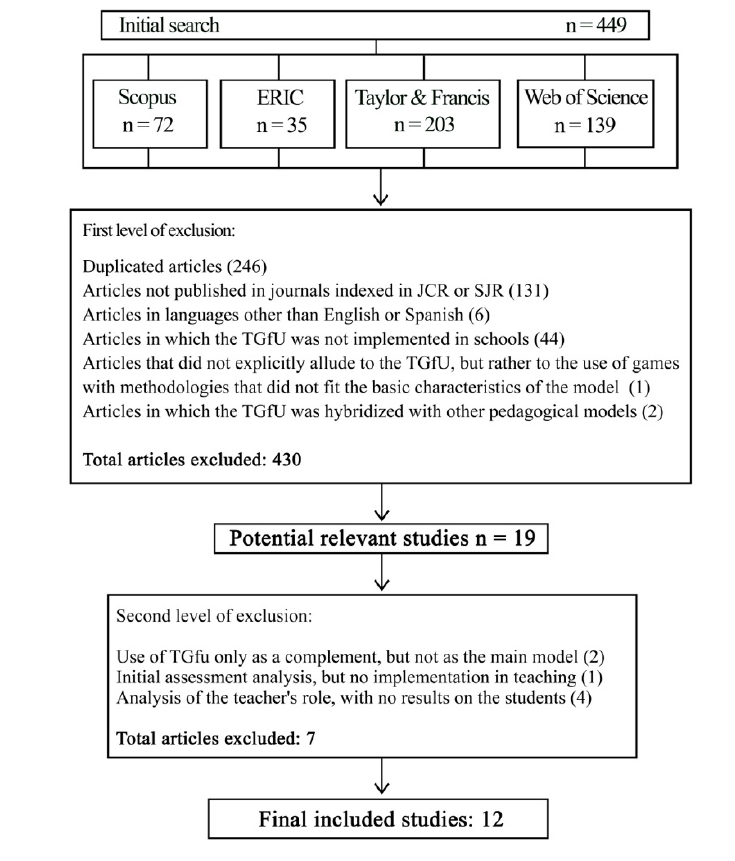
Figure 1. Flow diagram of the systematic search process. Table 1. Investigation quality score